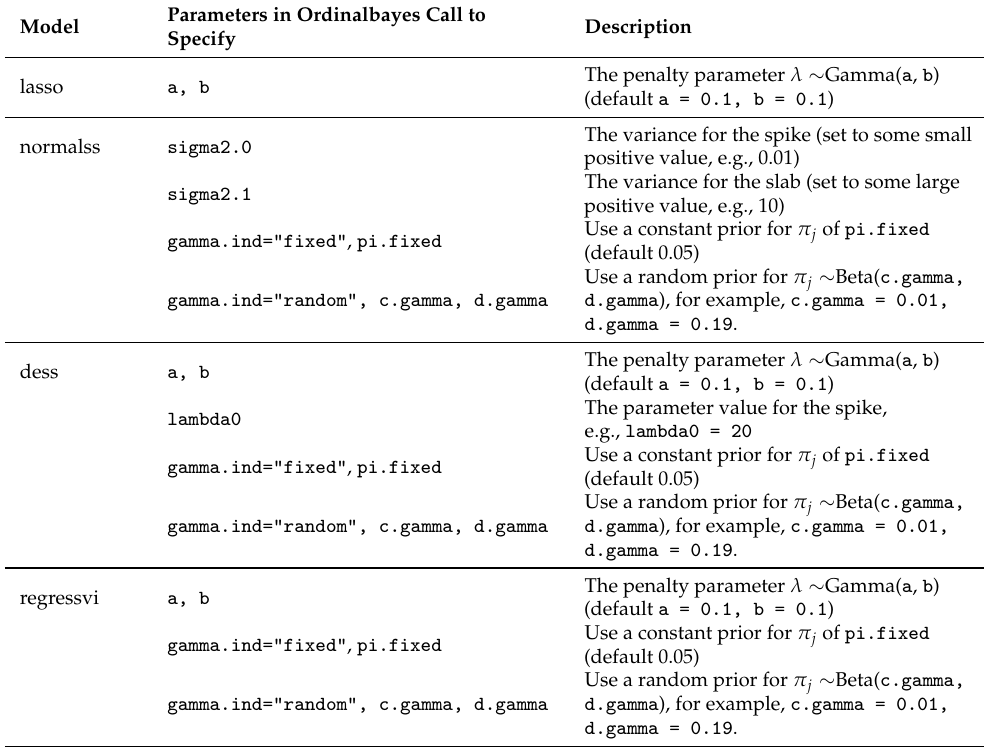
Table A2. ordinalbayes parameters for each penalized ordinal Bayesian